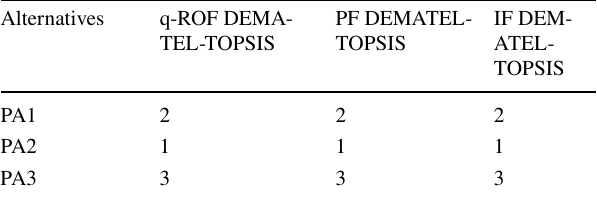
Table 17 Comparative ranking results of the population-based strate- gic priorities for the vaccine hesitancy